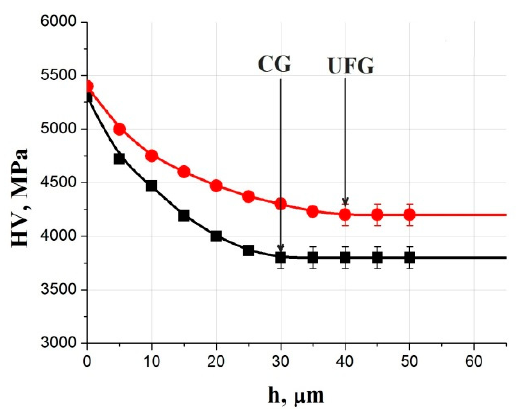
Figure 9. Microhardness behavior over the depth of UFG and CG substrates of a Ti ‐ 6Al ‐ 4V alloy after high ‐ energy nitrogen ion implantation.